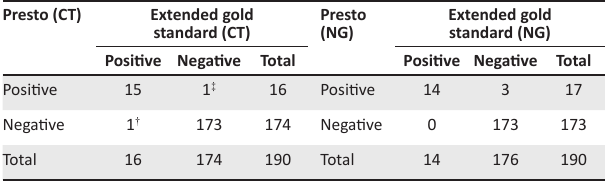
TABLE 2: Cross-tabulation of the Presto CT/NG PCR assay and extended gold standard Chlamydia trachomatis and Neisseria gonorrhoeae results